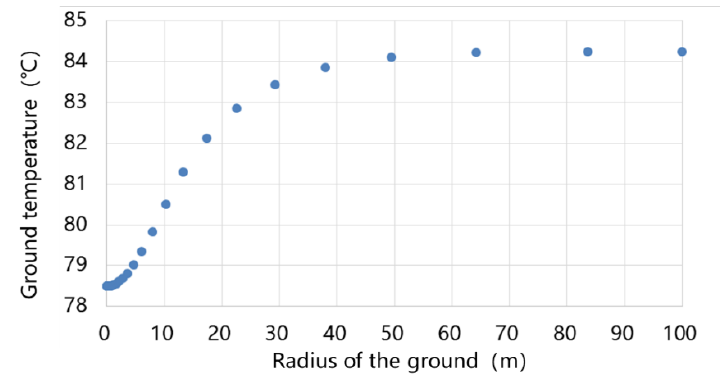
Figure 6. The ground temperature distribution in radius direction at the bottom of